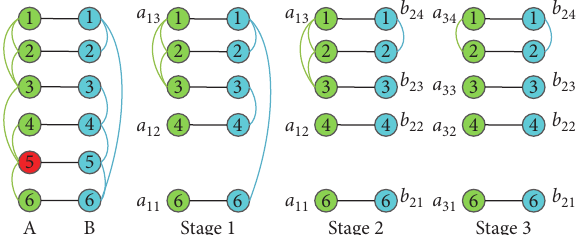
Figure 2: Dynamic network model for analyzing the robustness of multilayer networked systems with one-to-one correlations. Ini- tially, node 5 from network A is removed. Due to the O2O cor- relations, node 5 in network B is also eliminated in Stage 1 and network A breaks into three clusters, denoted by a In Stage 2, nodes 4 and 6 both in networks A and B together with the links attached to them are removed, and network B breaks into four clusters, namely, b network A is removed and network A breaks into four clusters. Because in Stage 3 no further link elimination and network breaking occur, the cluster consisting of a